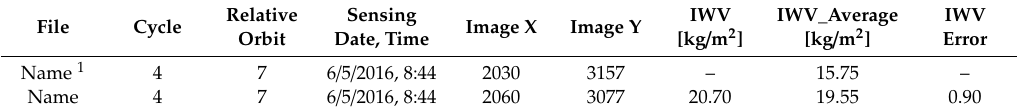
Table 1. A typical example of the output of the custom script developed to determine the IWV values from OLCI imagery. Each row corresponds to the image pixel that contains each GNSS station. If the OLCI image is not-cloud free then the respective cell will be left empty. For each image, the IWV value and its error has been obtained for all twelve GNSS stations. Furthermore, the average of the IWV values of the nearest plus its neighboring pixels (30 × 30 pixels) are also determined and archived.